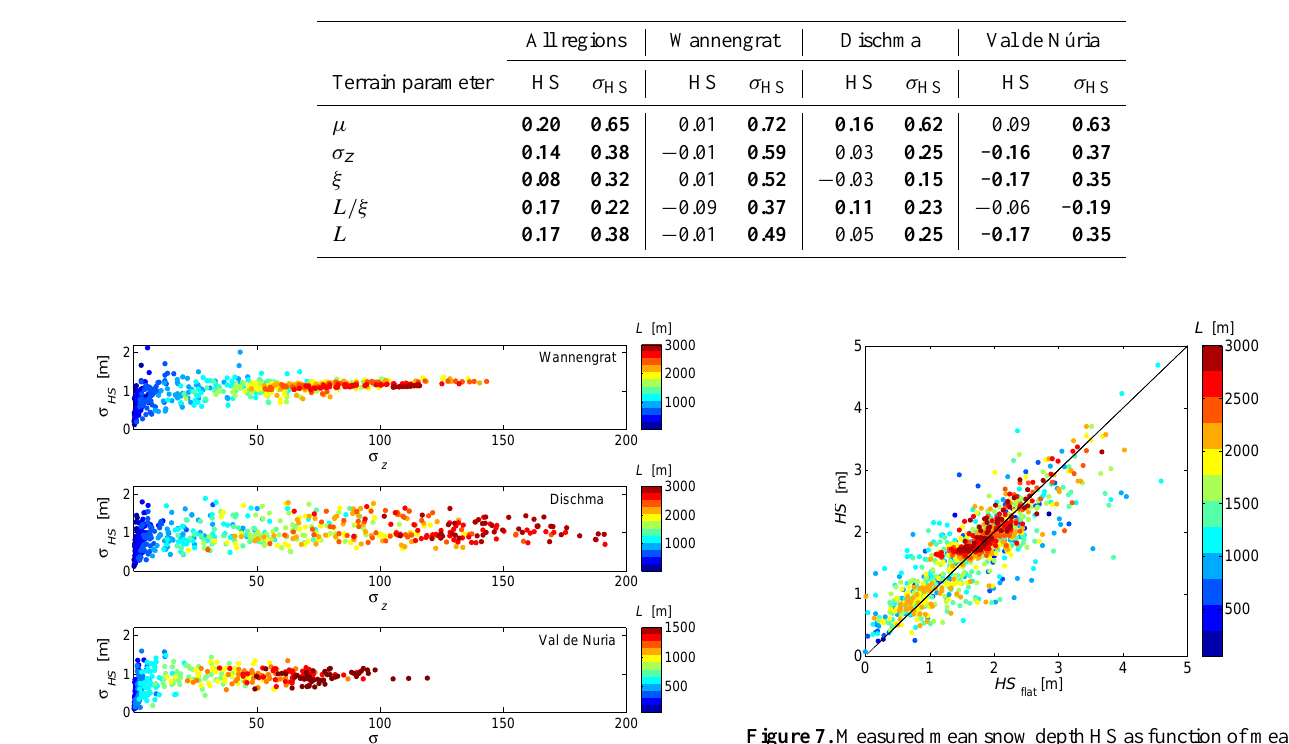
Figure 7. Measured mean snow depth HS as function of mean mea- sured flat field HS flat for all three areas. Colors indicate correspond- ing domain size L